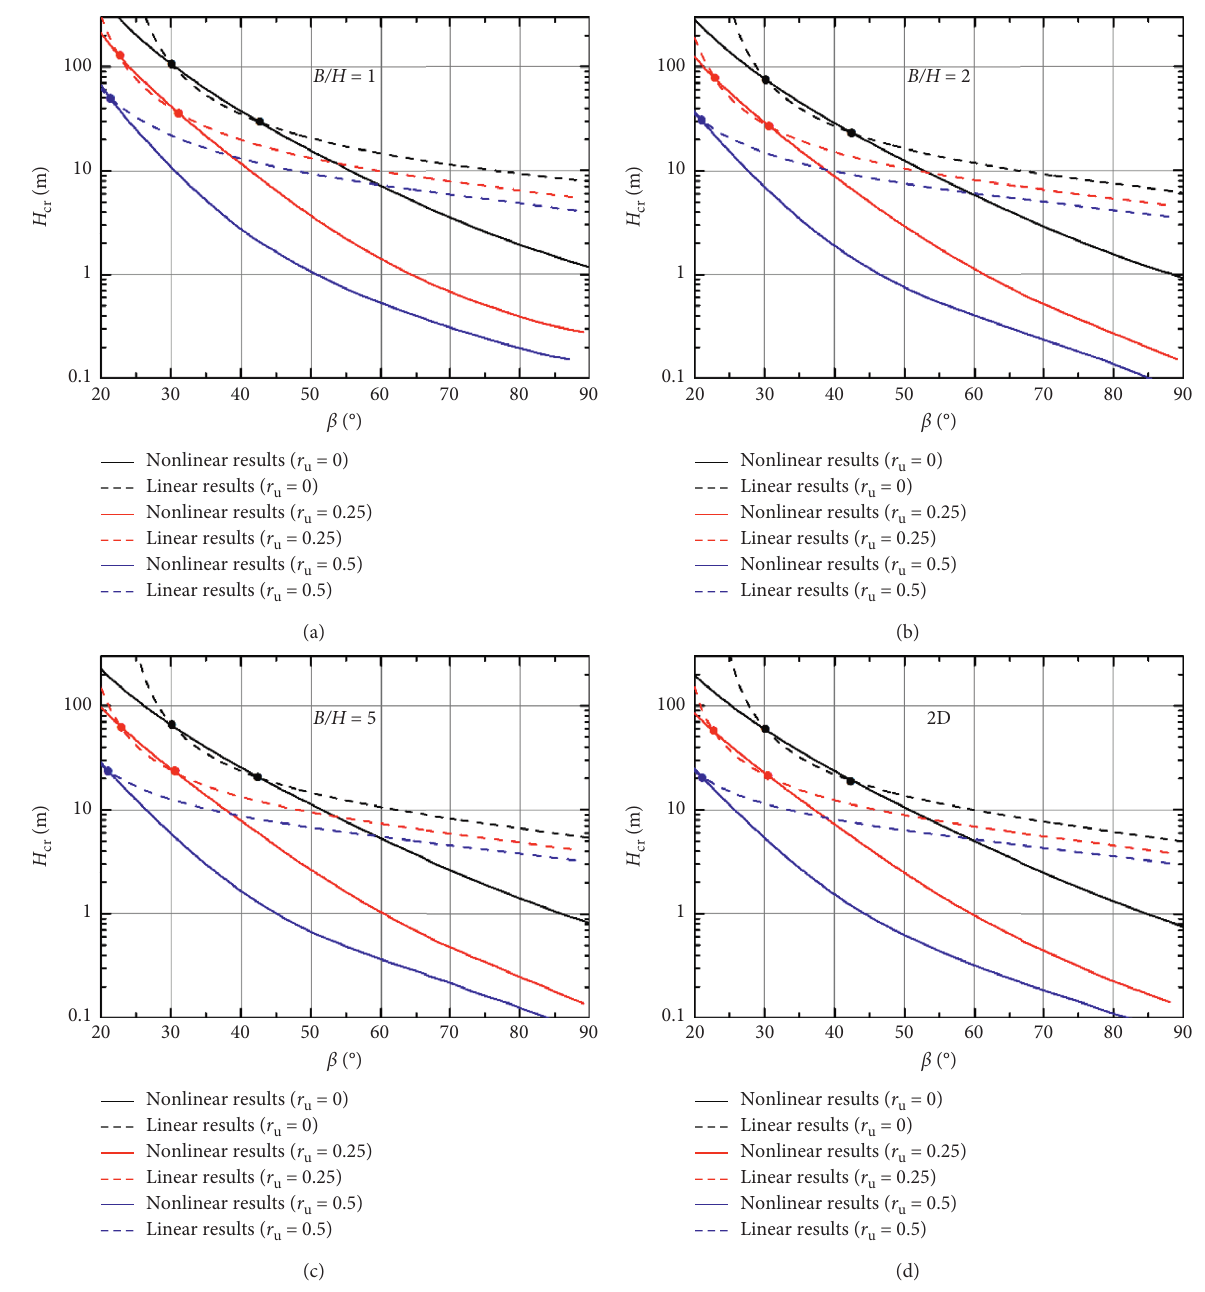
Figure 9: Critical heights of Upper Lias clay slopes undergoing different pore-water pressures. (a) B/H � 1. (b) B/H � 2. (c) B/H � 5. (d)